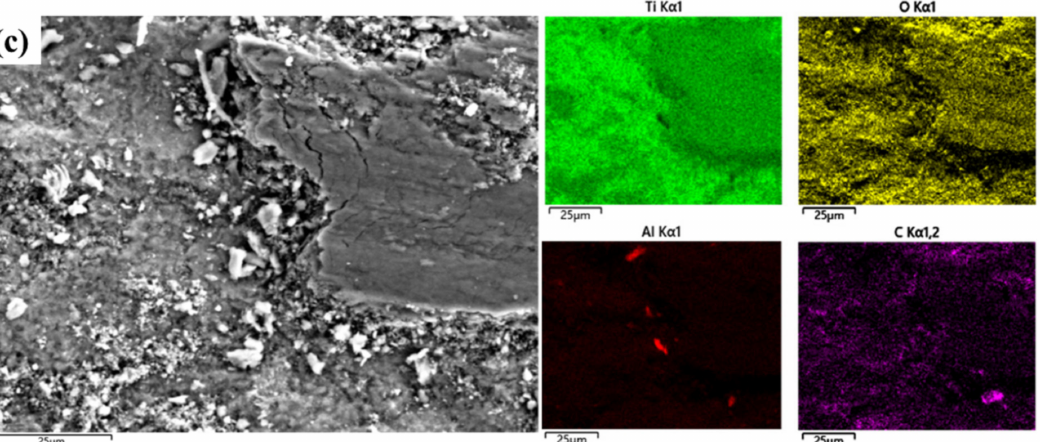
Figure 8. EDS of MAO layer on TC4 alloy with different particle additions: ( a ) MAO, ( b ) Ti 3 SiC 2 , ( c ) Ti 3 AlC 2 .